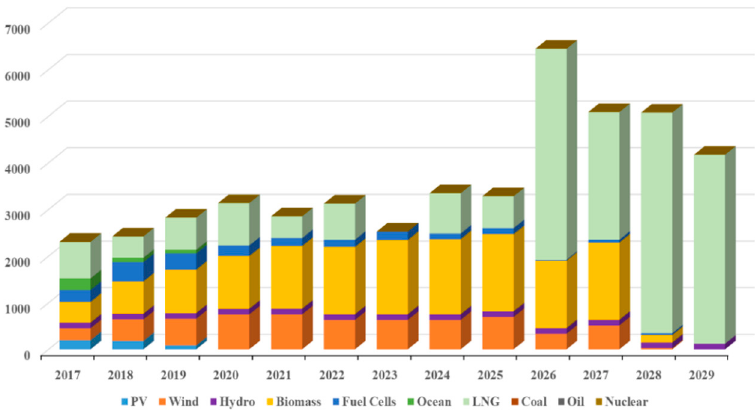
Figure 10. Newly installed capacity of each energy source in SC2.